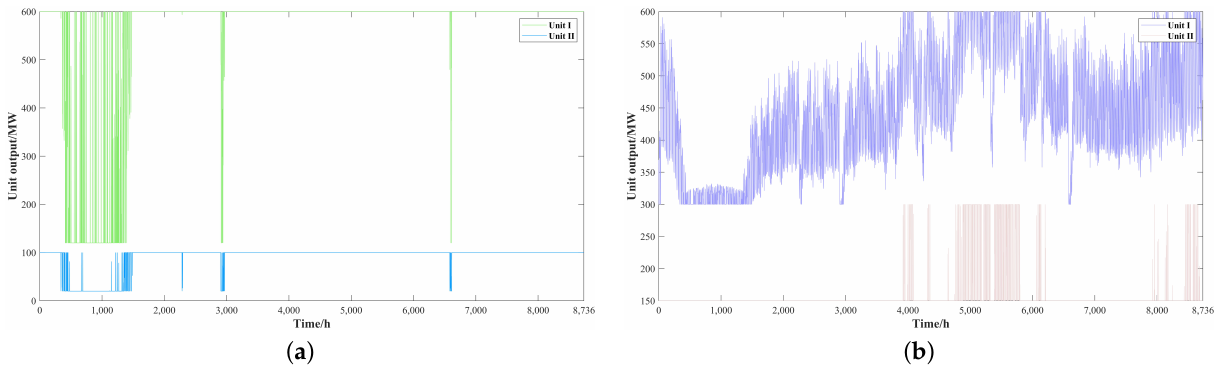
Figure 11. The output power curve of the unit in the entire time period of case B. ( a ) The output power curve of hydroelectric power units. ( b ) The output power curve of hydroelectric thermal power units.